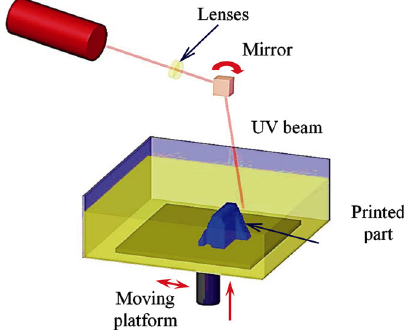
Fig. 4 A schematic diagram of VP